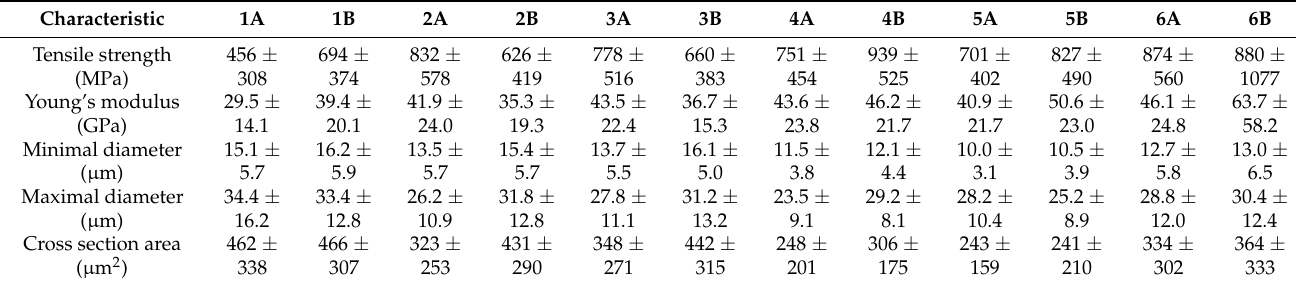
Table 8. Tensile properties, minimal diameter, maximal diameter, and cross section area of individual fibres inside all the final laps